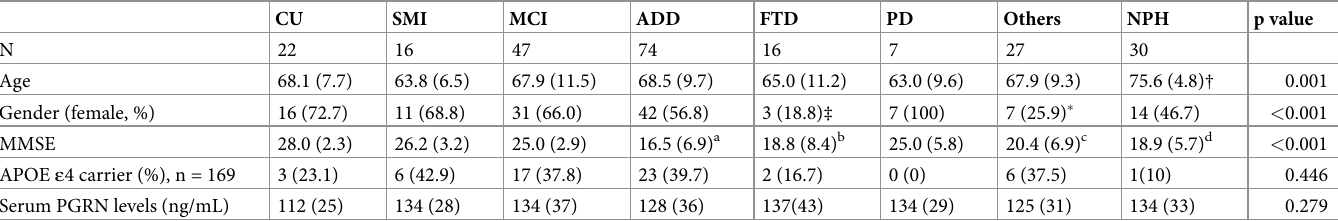
Table 1. Demographic characteristics and serum PGRN level according to clinical diagnostic